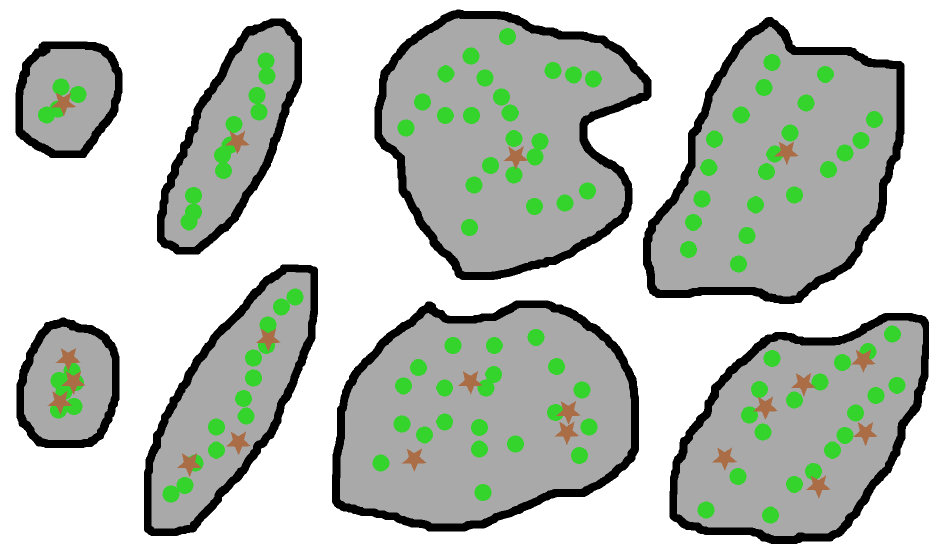
Figure 14. Scheme of the classification of the LJ-producing thunderstorms according to the number of jumps (brown stars): SLJsts ( above ) or MLJsts ( below ). The shadowed grey area indicates the limits of the thunderstorm based on the reflectivity footprint, while the green dots correspond to the cells identified using the algorithm of [21]. From left to right : isolated (a unique convective cell with a reduced path), lineal (a unique convective cell with a large trajectory), unorganised (multiple convective cells following unconnected paths), and organised (multiple cells with parallel or quasi-parallel trajectories, or the result of the splitting and merging processes).